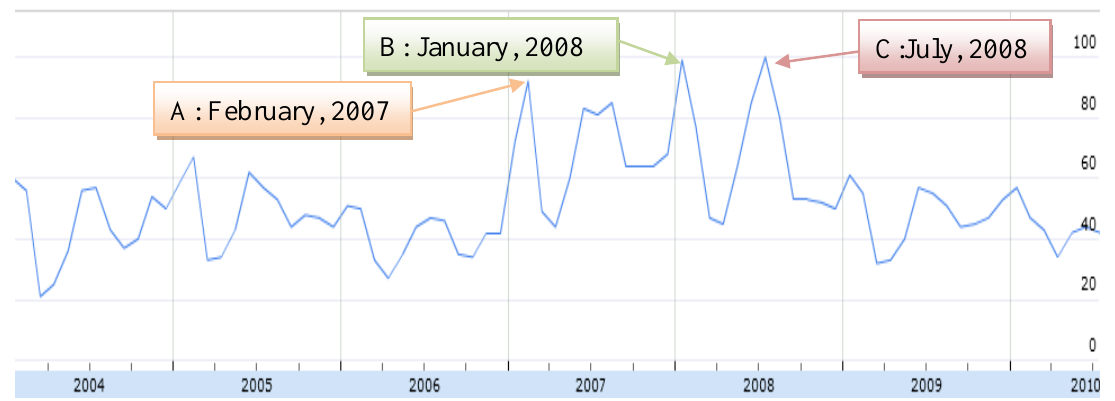
Figure 1. Index of interest shown in search term “Chikyu Ondanka”(Graph generated by Google Insights for Search on 19 July